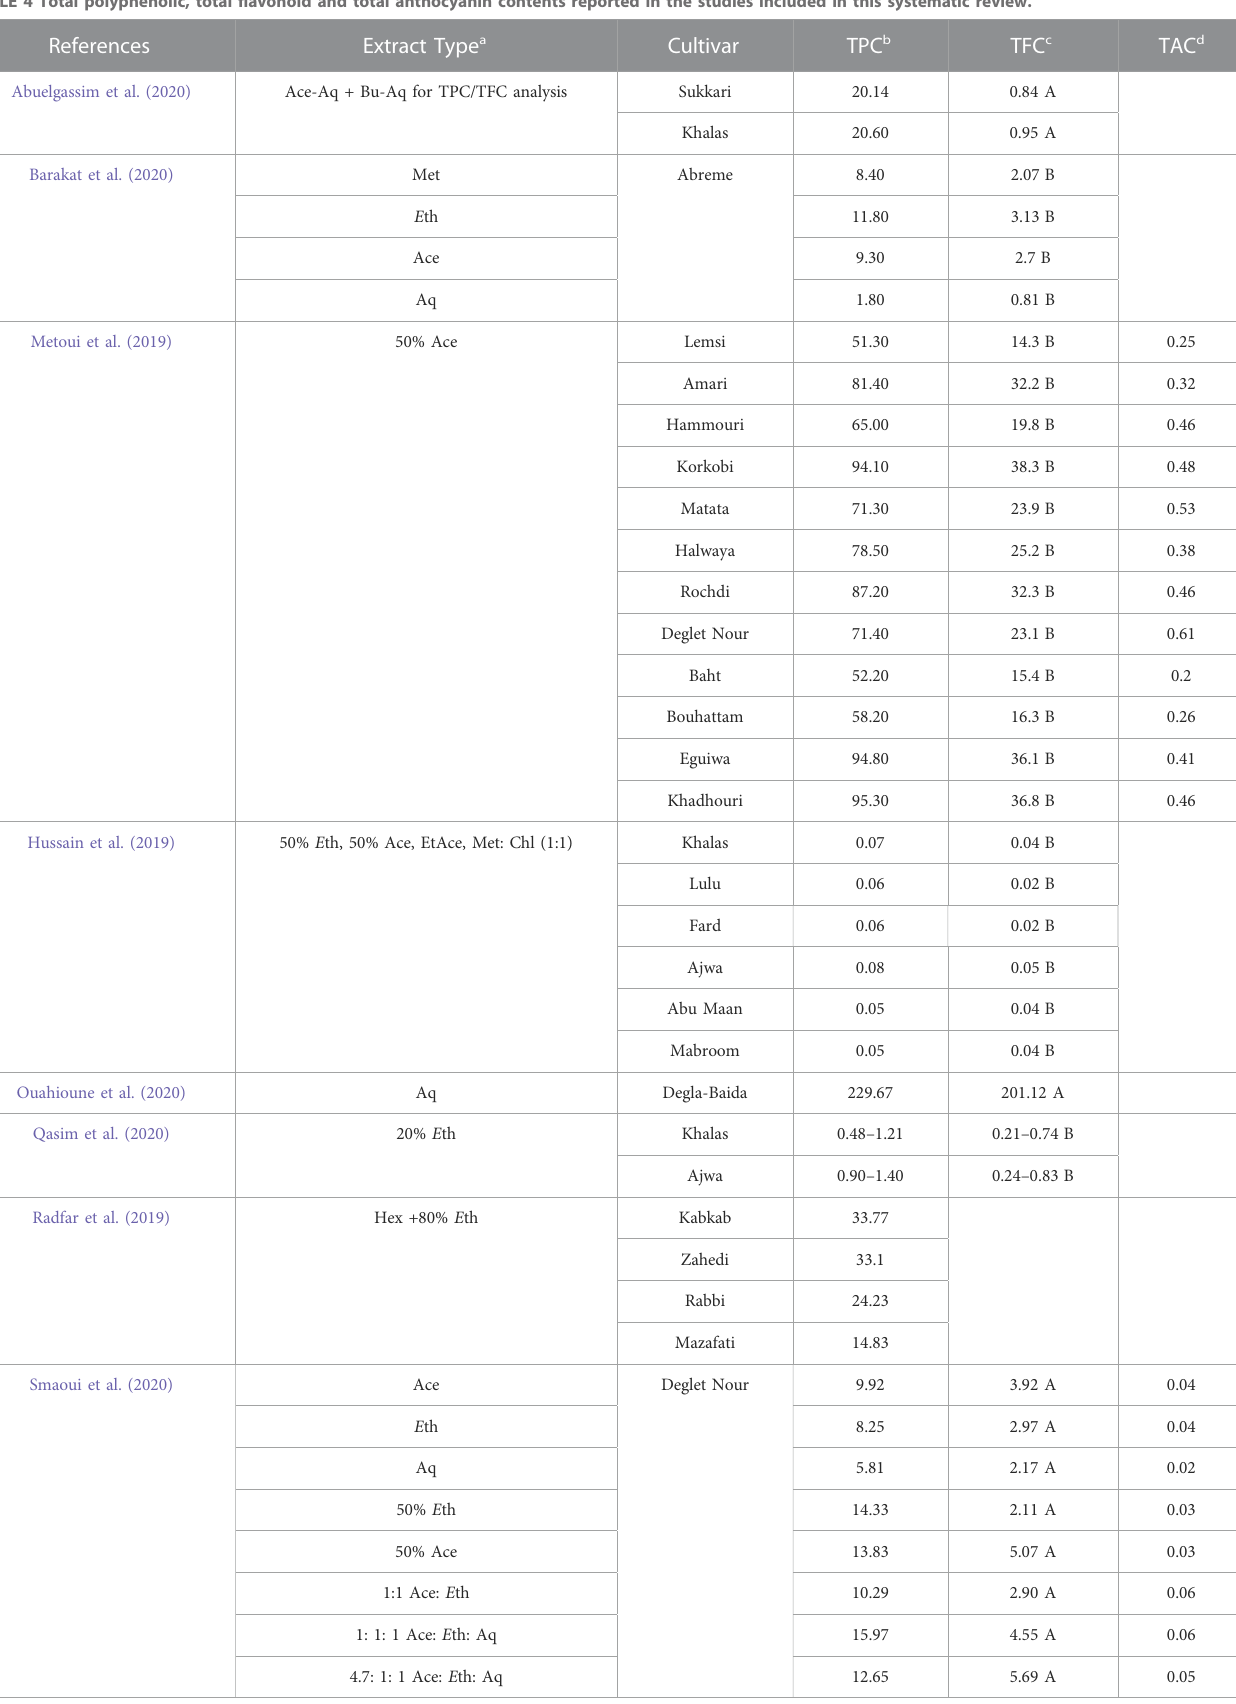
TABLE 4 Total polyphenolic, total fl avonoid and total anthocyanin contents reported in the studies included in this systematic